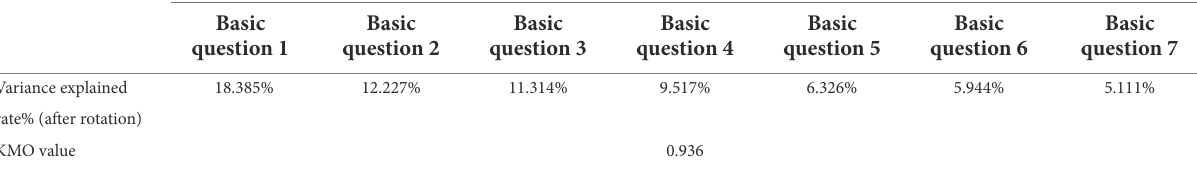
TABLE 3 Validity analysis